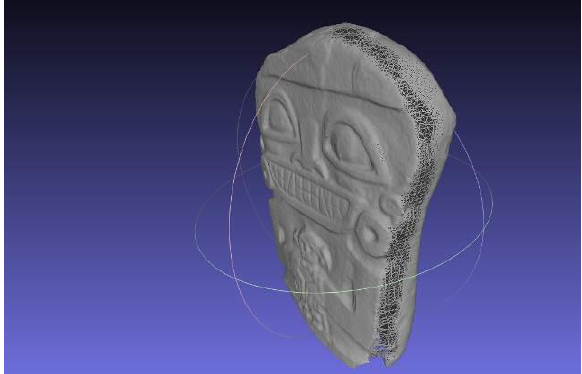
Figure 6. “Escultura 202”. Missing points on the lateral parts and on the top.